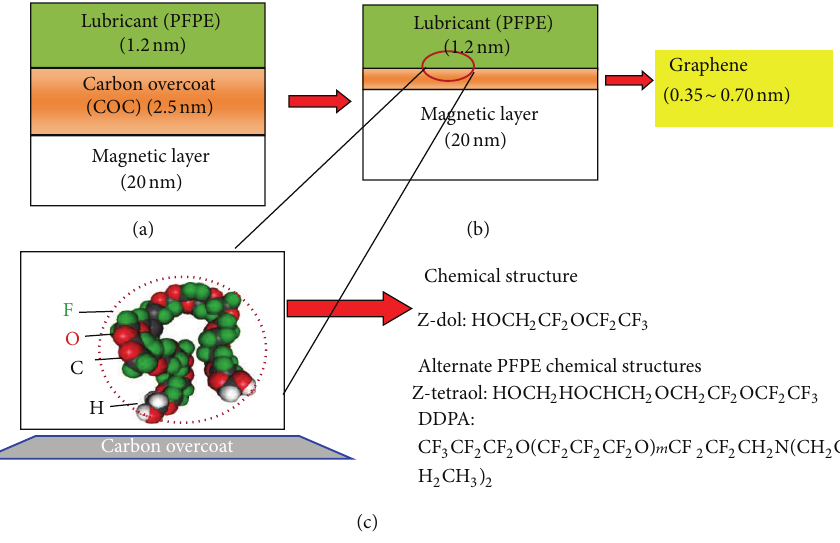
Figure 23: HDI configuration and graphene for the COC